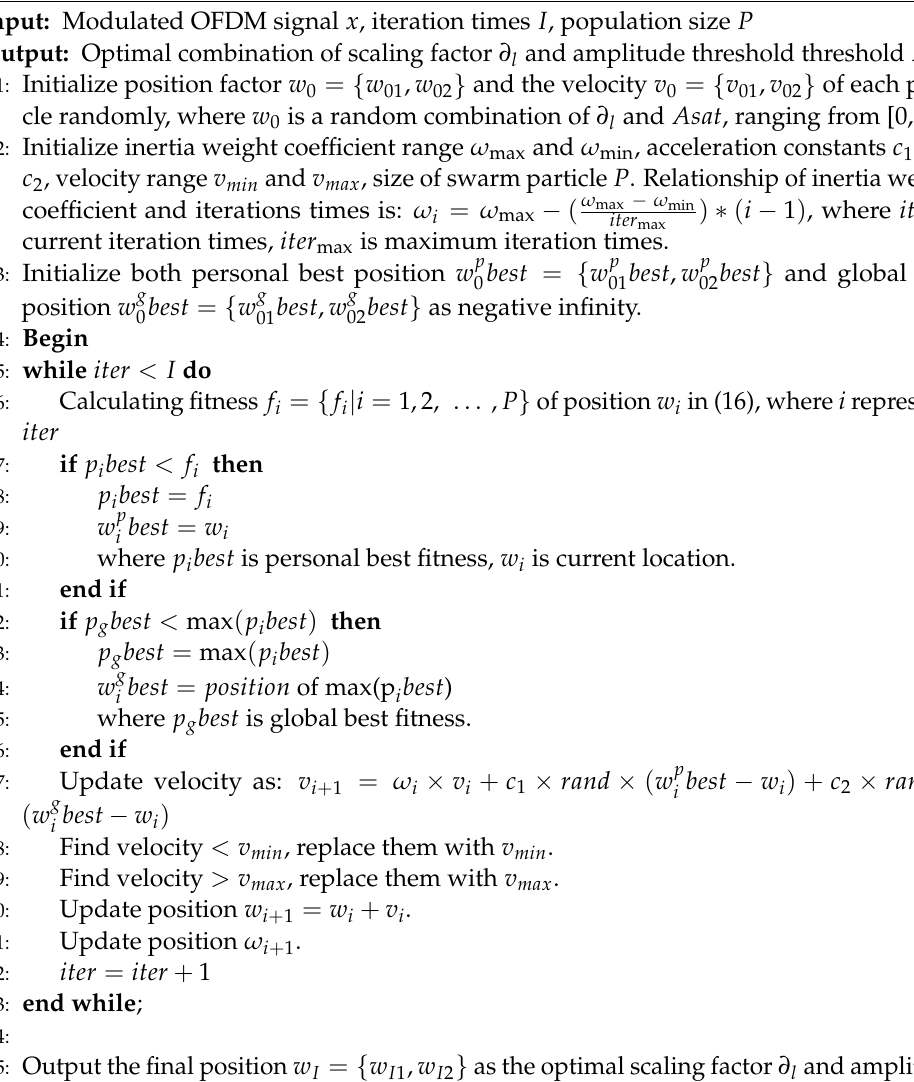
The FPSOPSO-TR Algorithm 1 is given in Table 1 in detail. Algorithm 1 Particle swarm optimization based on FPSO-TR calculation.